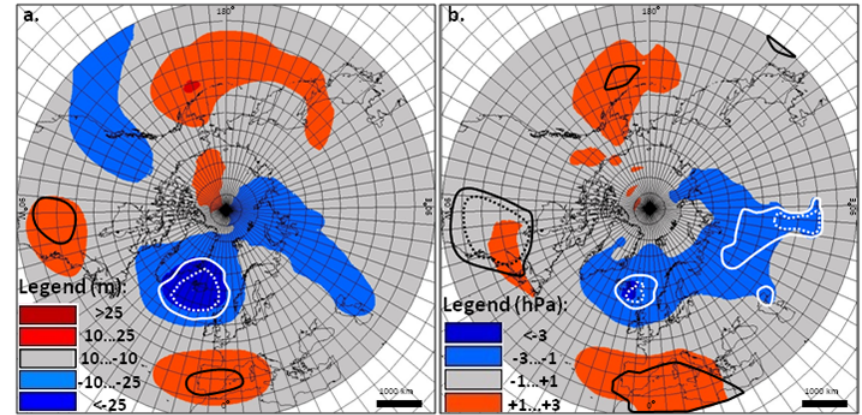
Figure 1. Mean difference between months with high and low solar activity for the 500hPa GPH (in metres) (left) and SLP (in hPa) (right), for winter. Regions with statistical significance of differences are delimited by continuous (10% significance level) and dotted (5% level) lines, indicating positive (black) and negative (white)